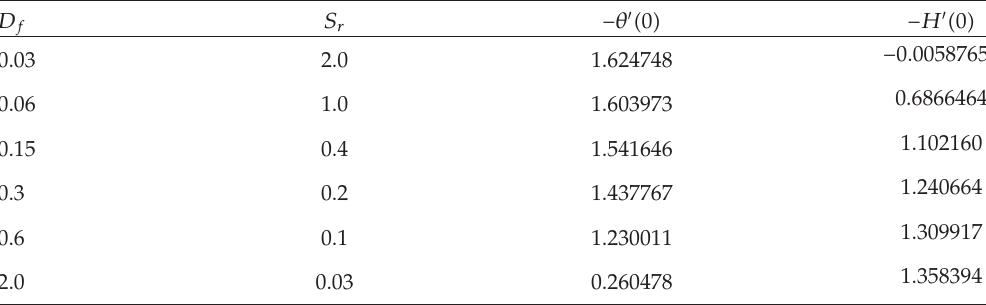
Table 4: The values of − θ (cid:5) (cid:5) 0 (cid:6) and − H (cid:5) (cid:5) 0 (cid:6) with di ff erent parameters D f and S r